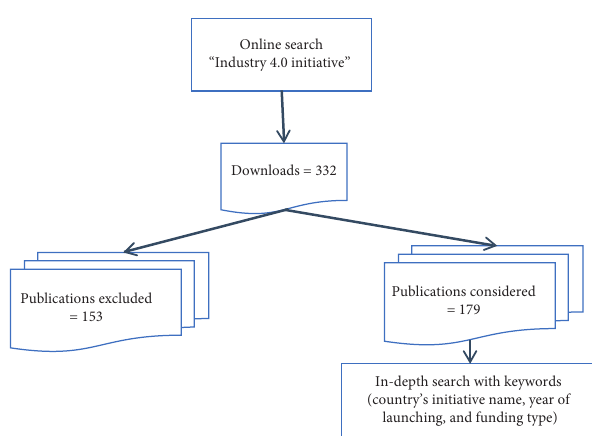
Figure 1: Flowchart illustrating the literature search strategy